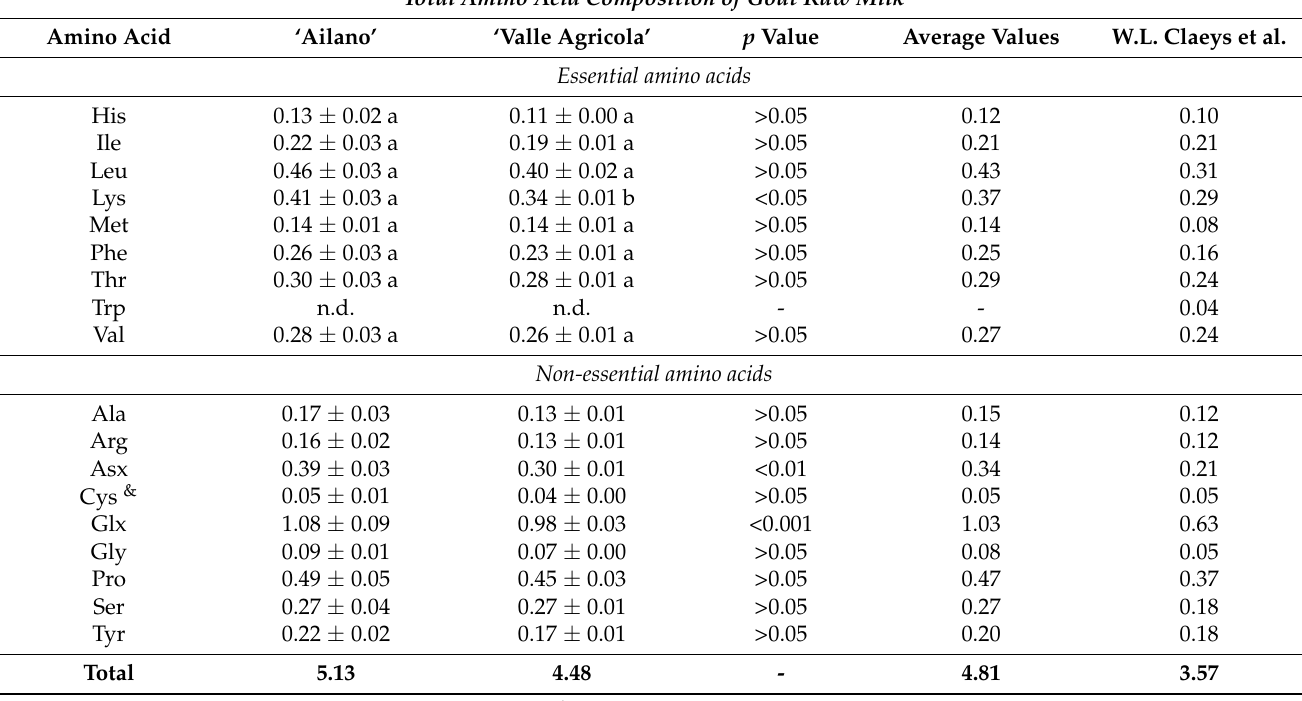
For protein amino acids, a three-letter code has been used. & Cys amount was evaluated after performic acid oxidation. n.d. not determined. Values followed by different letters within a row are significantly ( p < 0.05) different by Bonferroni